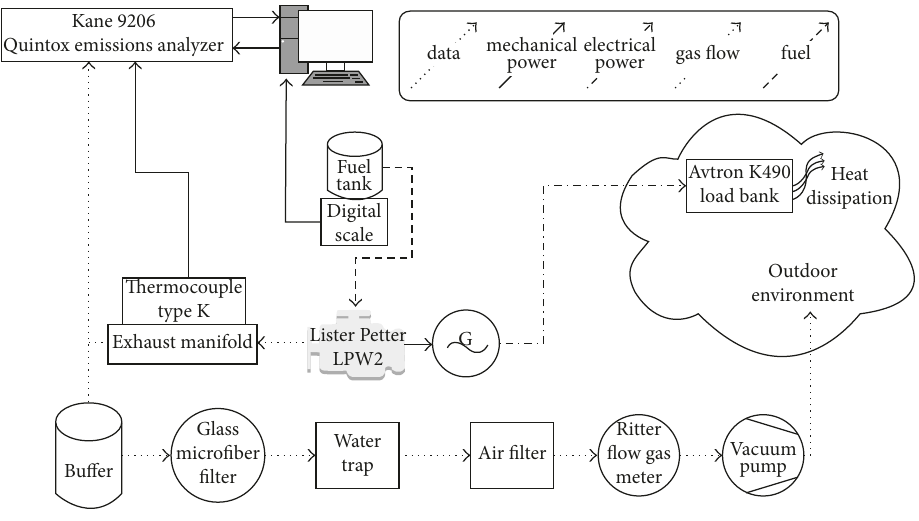
Figure 2: Experimental setup